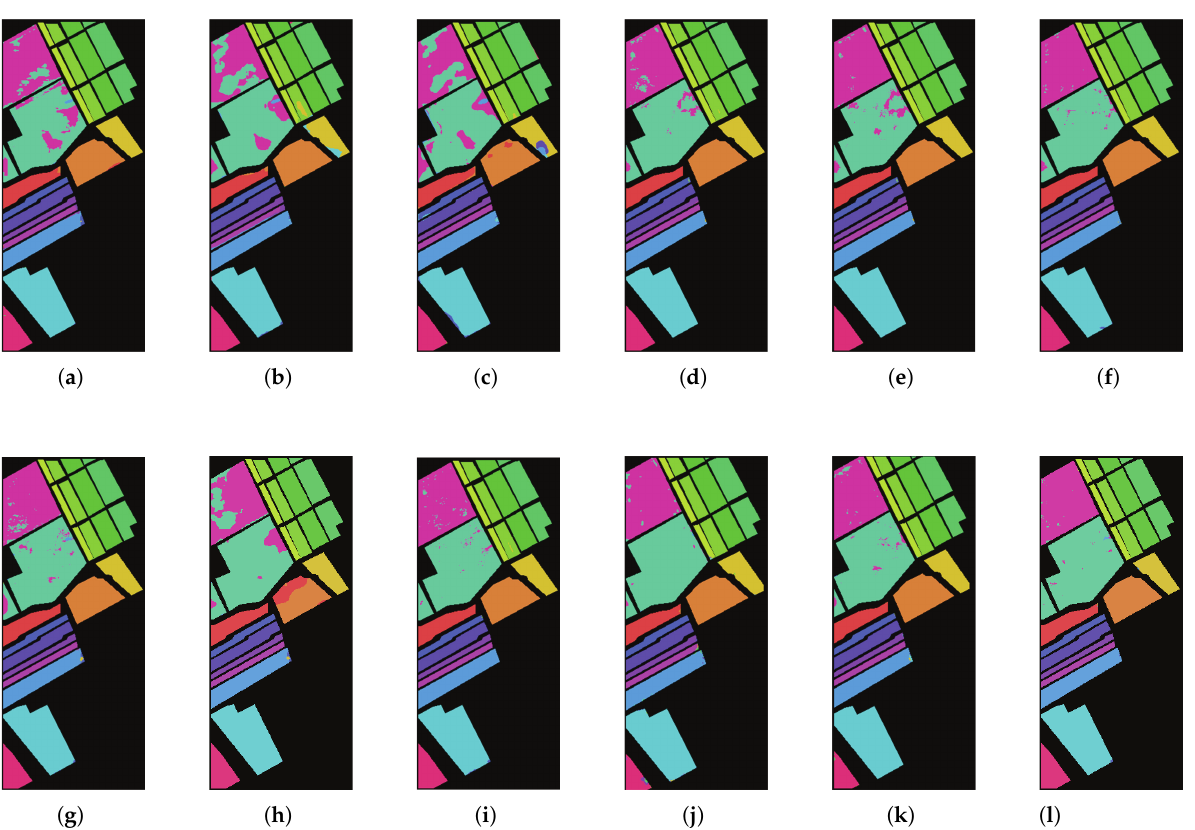
Figure 9. Classification maps for SA data set. ( a ) SVM. ( b ) RF. ( c ) MLR. ( d ) ResNet. ( e )